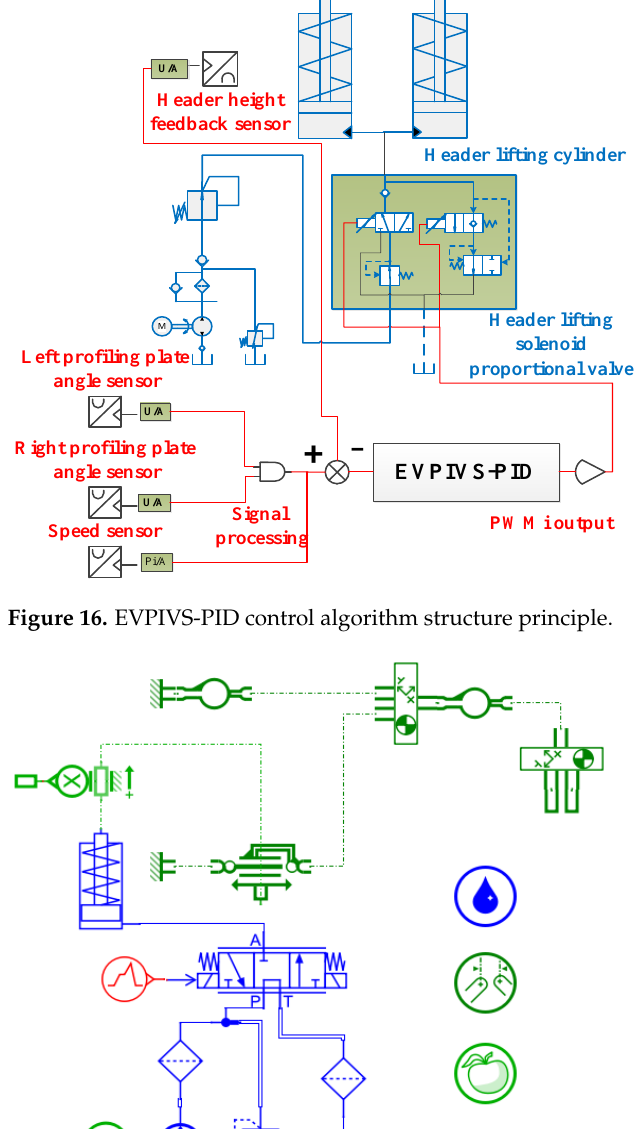
electromagnetic proportional valve adjusts the hydraulic system in accordance with the discussion in Section 2.3 and pushes the header to adjust the lifting and lowering. The height feedback sensor of the header feeds back the actual height of the header in real time.